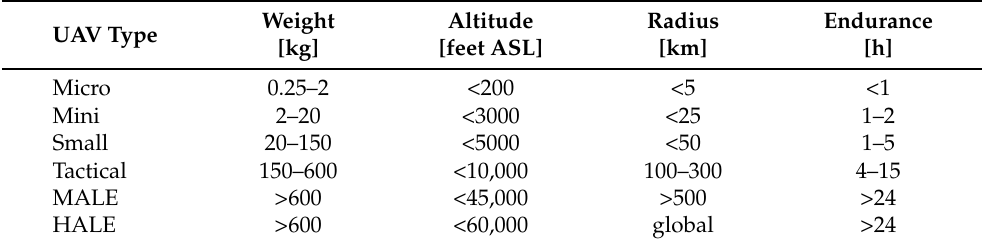
Table 2. Classification of UAVs according to the US Department of Defense [25].